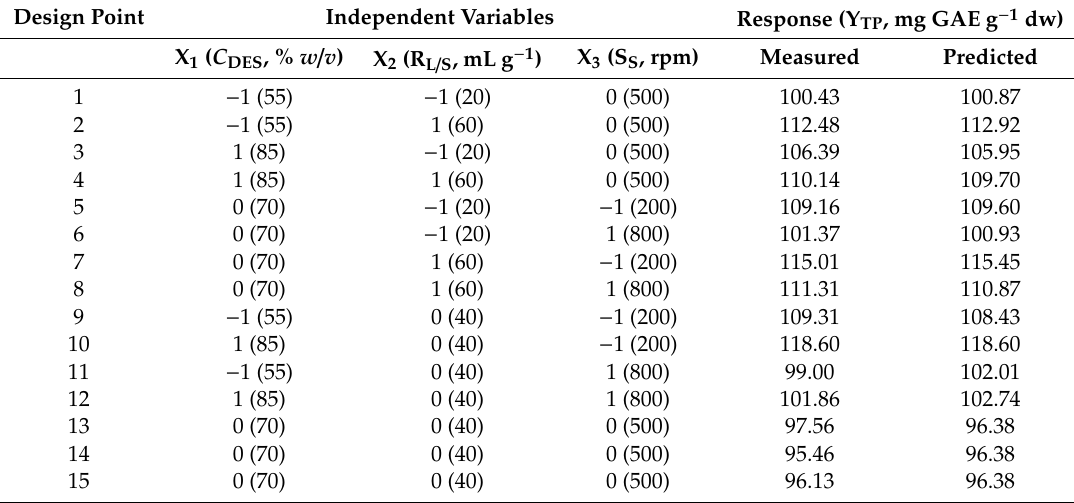
Table 3. Measured and predicted values of the response for all design points